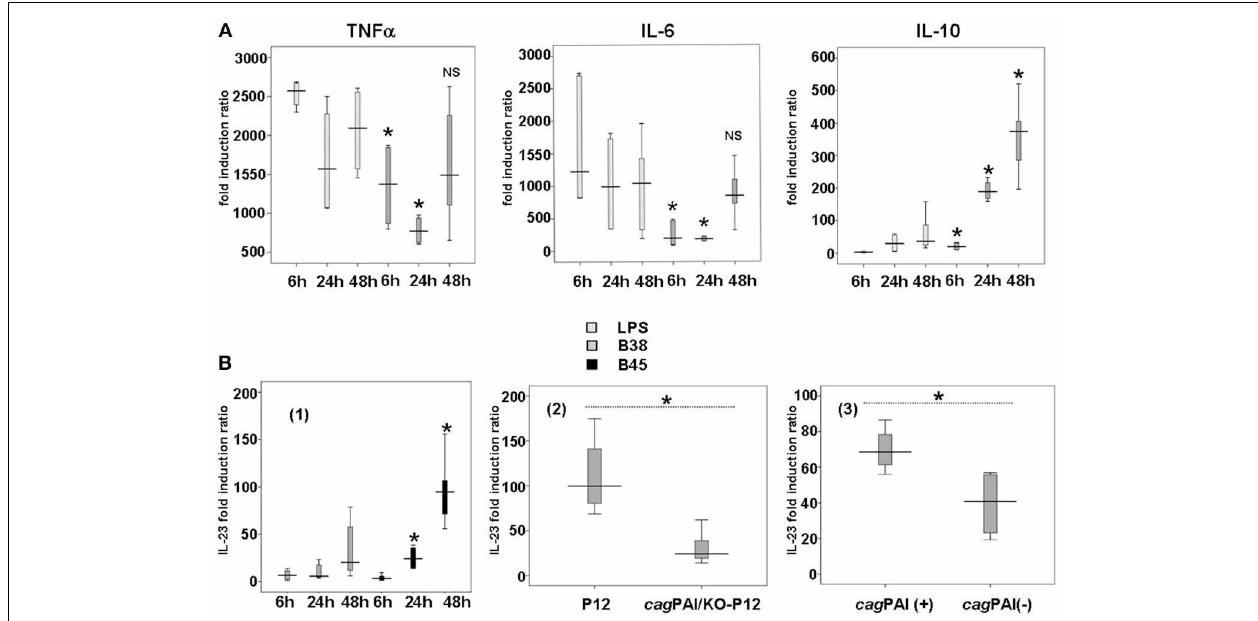
FIGURE 1 | Cytokine production in H. pylori -activated dendritic cells. (A) Kinetics of TNF α , IL-6, and IL-10 secretion by E. coli LPS- or H. pylori -activated dendritic cells. DCs were either stimulated with E. coli LPS (100ng/ml) or cocultivated with B38 H. pylori strain at MOI 1 for 6, 24, or 48h. TNF α , IL-6, and IL-10 secretion in the culture supernantants was evaluated by flow cytometry (as described in Materials and Methods). The horizontal bar across the box indicates the median and the capped bars indicate the minimum and maximum data values of fold induction ratio vs. DCs alone obtained for 6 independent experiments corresponding to 6 different donors. These results are representative of the results obtained for H. pylori strain B45 for the same experiments. *for p < 0 . 05 and NS for p > 0 . 05 compared to E. coli LPS at the corresponding time-point. (B) Influence of the H. pylori cag PAI on the production of IL-23 by dendritic cells after H. pylori infection. (1) DCs were cocultured with B38 or B45